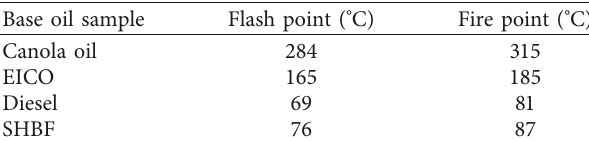
Table 8: Flash point and fire point of base fluid